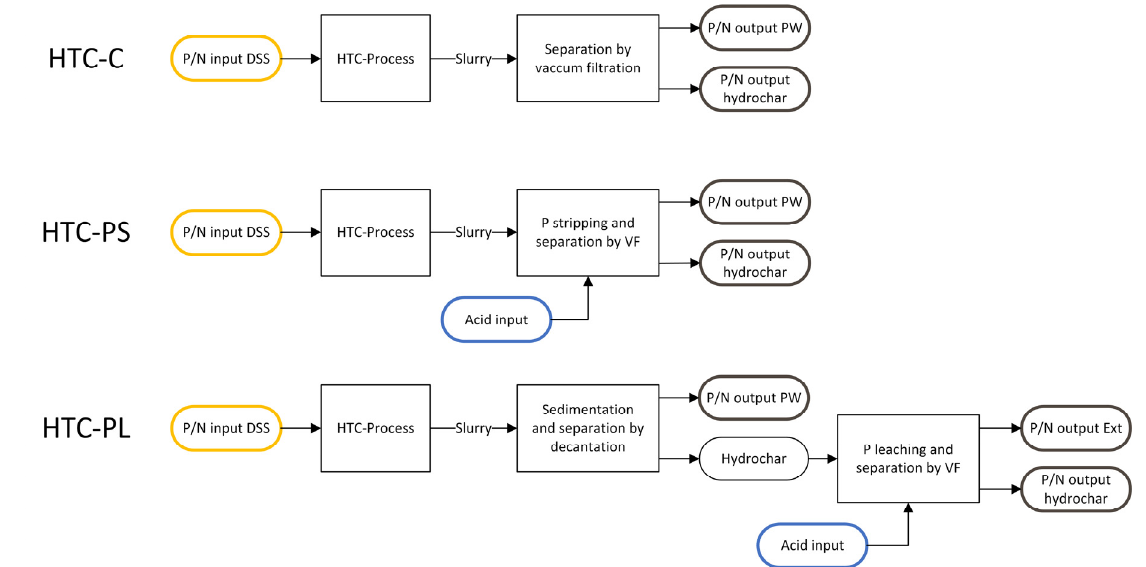
Figure 1. Flow charts of experimental set-ups with and without acid addition. (HTC = Hydrothermal carbonization, C = Control, PS = P-Stripping, PL = P-Leaching, DSS = Digested sewage sludge, PW = Process water, Ext = Leaching extract, VF = Vacuum filtration).